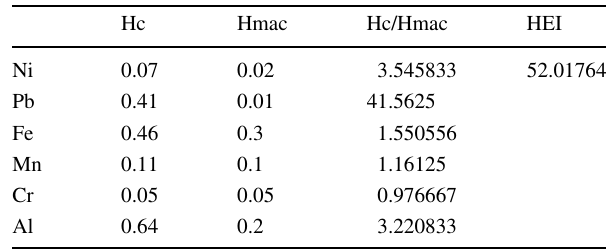
Table 6 Heavy metal evaluation index for groundwater at site 4